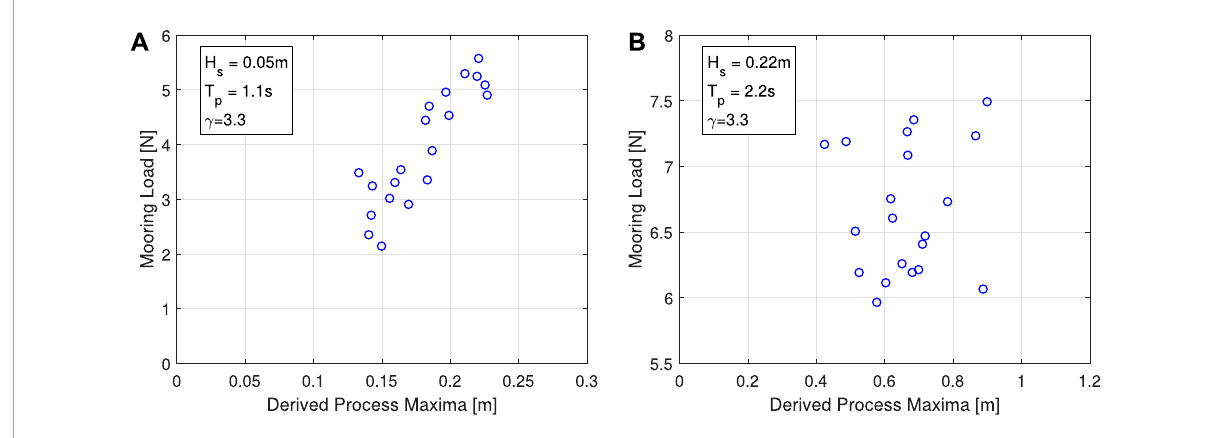
FIGURE 12 Maximum mooring load response as a function of derived process maxima for the CRRW runs, generated using the target wave profile (five preceding peaks with time interval T p ). Each SDW run for the Resonance sea state (A) and 50-year sea state (B) , are presented both with γ = 3 .